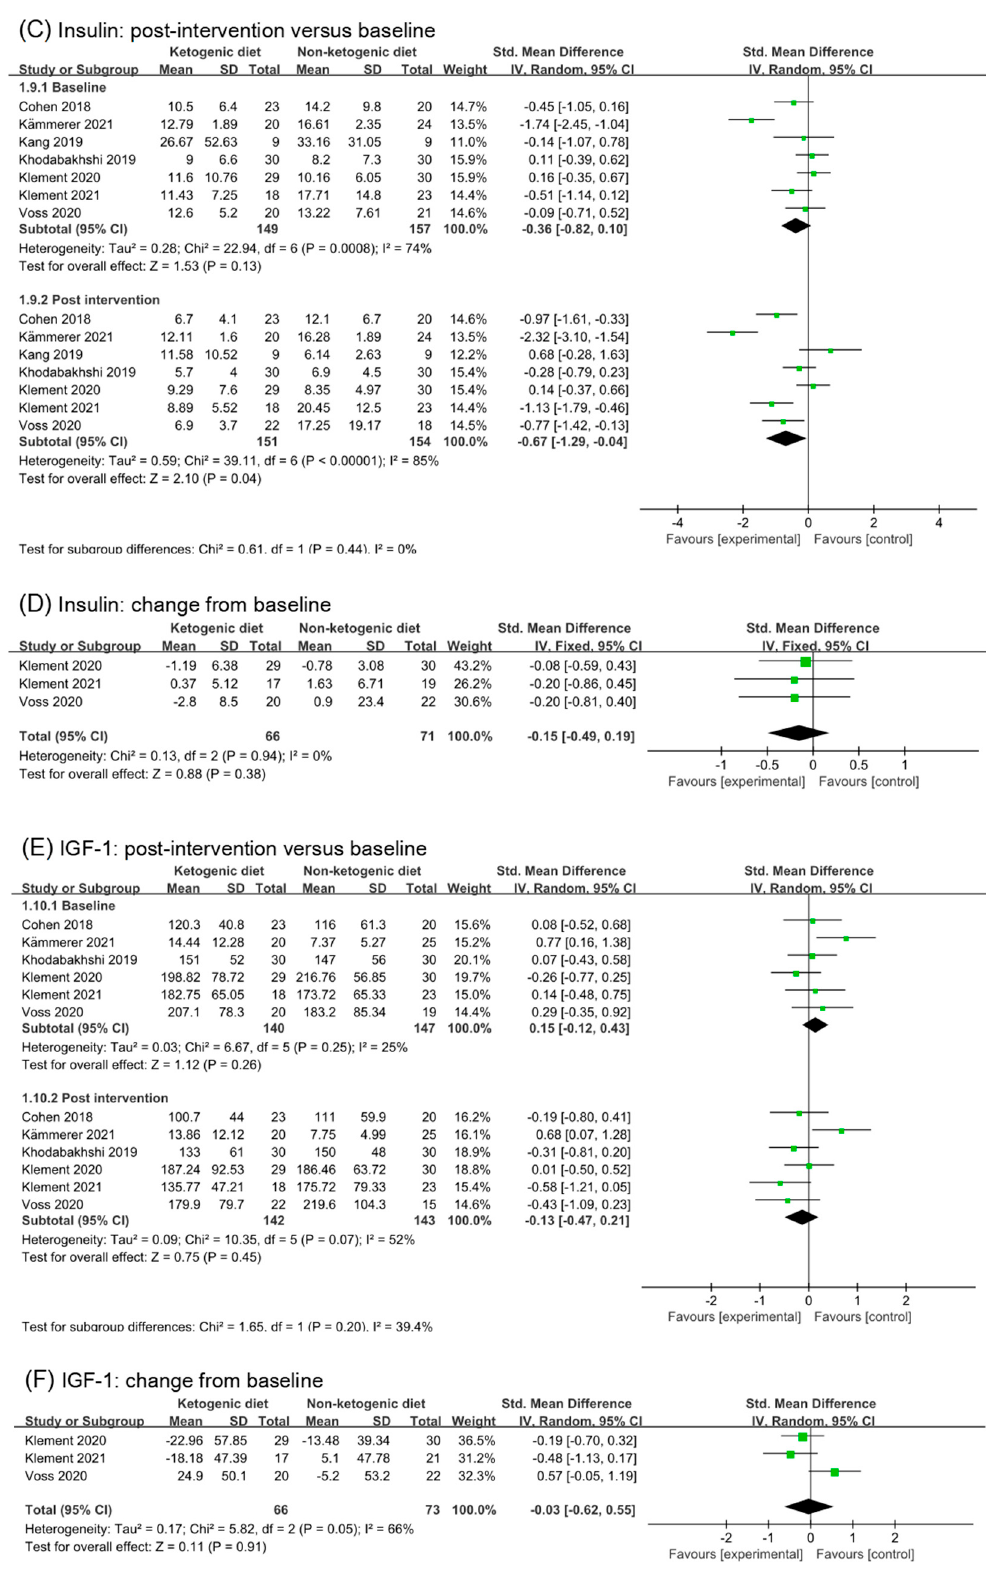
Figure 4. Forest plot for the effects of ketogenic diets on blood glucose, insulin and IGF-1. ( A , B ) were subgroup effects of the baseline versus post-intervention and effect of change from baseline on blood glucose; ( C , D ) were ones on insulin; ( E , F ) were ones on IGF-1 [26–28,30–33,35–42].